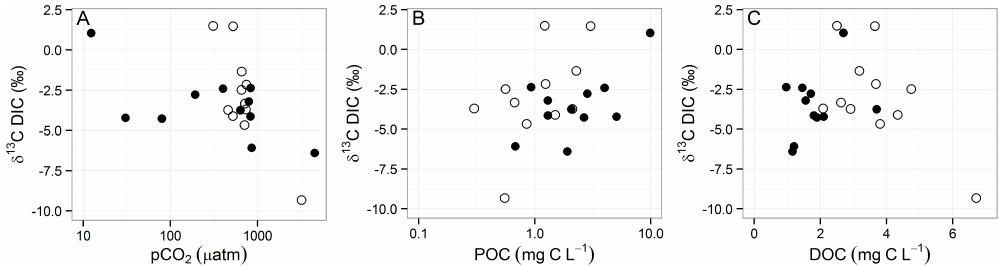
Figure 3. The relation of δ 13 C DIC in eutrophic lakes (filled circles, n = 11) and oligo-mesotrophic lakes (open circles, n = 11) to (a) p CO 2 ; (b) C phyto ; (c)